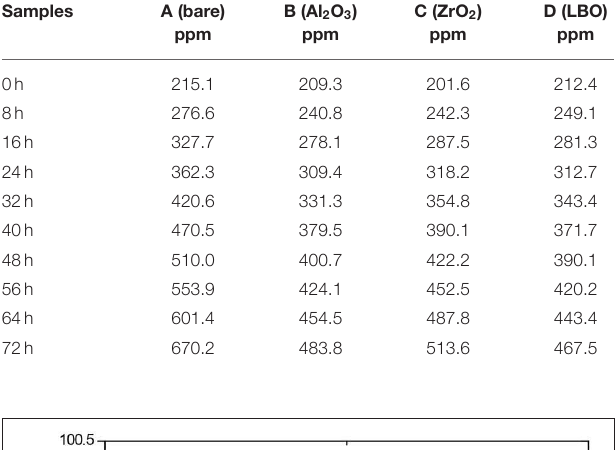
FIGURE 6 | First charge-discharge curves of the coin LIBs composed of NCM811 and NCM811 coated with different materials (A-uncoated, B-Coated by Al 2 O 3 , C-Coated by ZrO 2 , D-Coated by LBO).